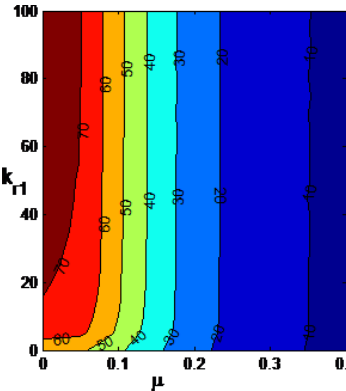
Figure 8. Stability boundaries with respect to q and p for k r0 = 0, k r1 = 0, k t = 10 8 (SS column) for various values of µ